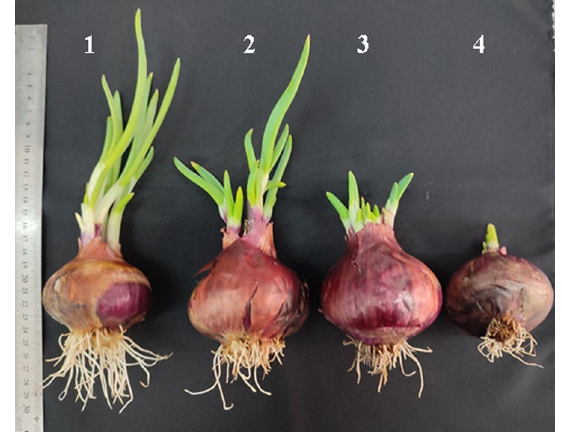
Fig. 3 Allium cepa treated with 1 tap water as control, 2 25%, 3